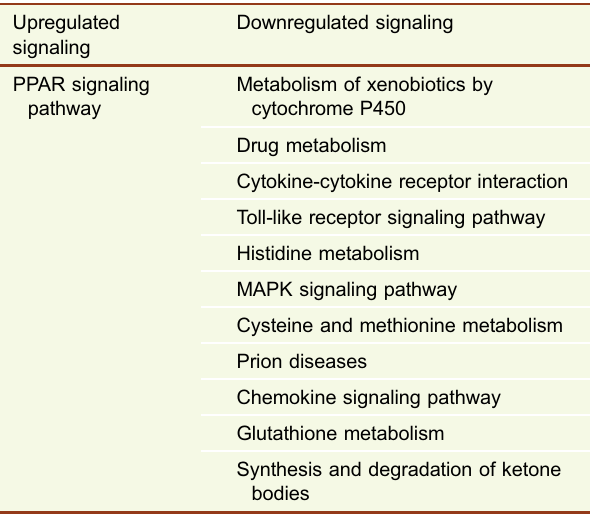
Table 2. DAVID gene function classi fi cation of change genes in KI mouse